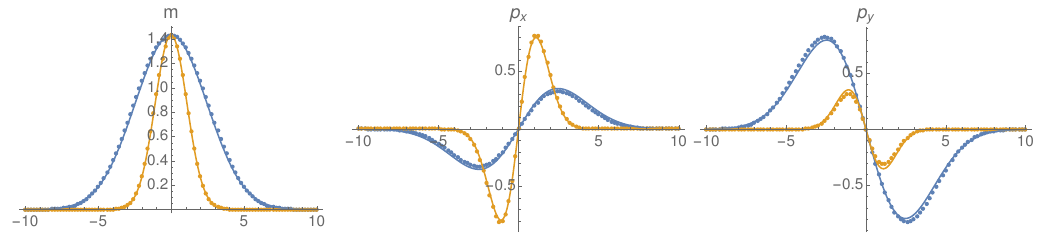
Figure 8 . Values of the pro(cid:12)les at t (cid:25) 22 along the principal axes, in blue and yellow. The data points correspond to the numerical data, while the solid lines show the analityc pro(cid:12)les in (2.21), (2.22). The value of (cid:10) is obtained from our initial data, while m max is extracted from the